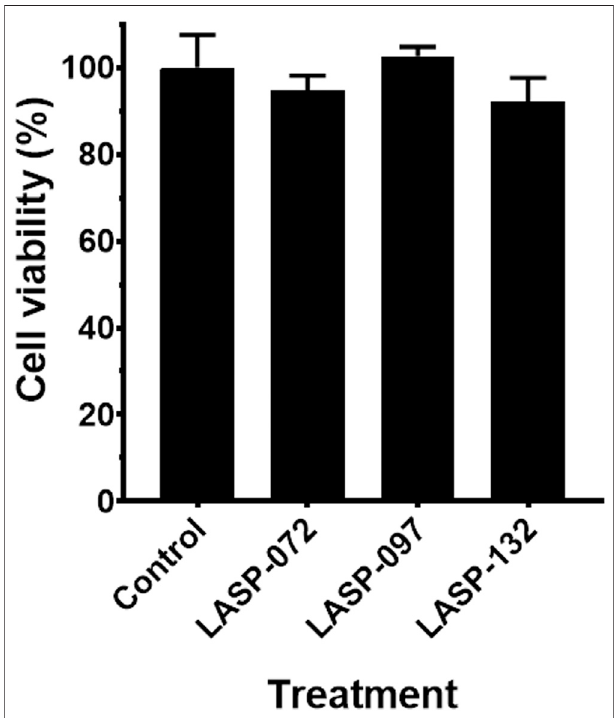
FIGURE 6 | Cell viability (%) of the A549 cells treated with LASP-072, LASP-097 and LASP-132 (0.04 mM, 24 h) using XTT assay (mean ± SD; n = 4). Tukey ’ s multiple comparisons test was performed and p >